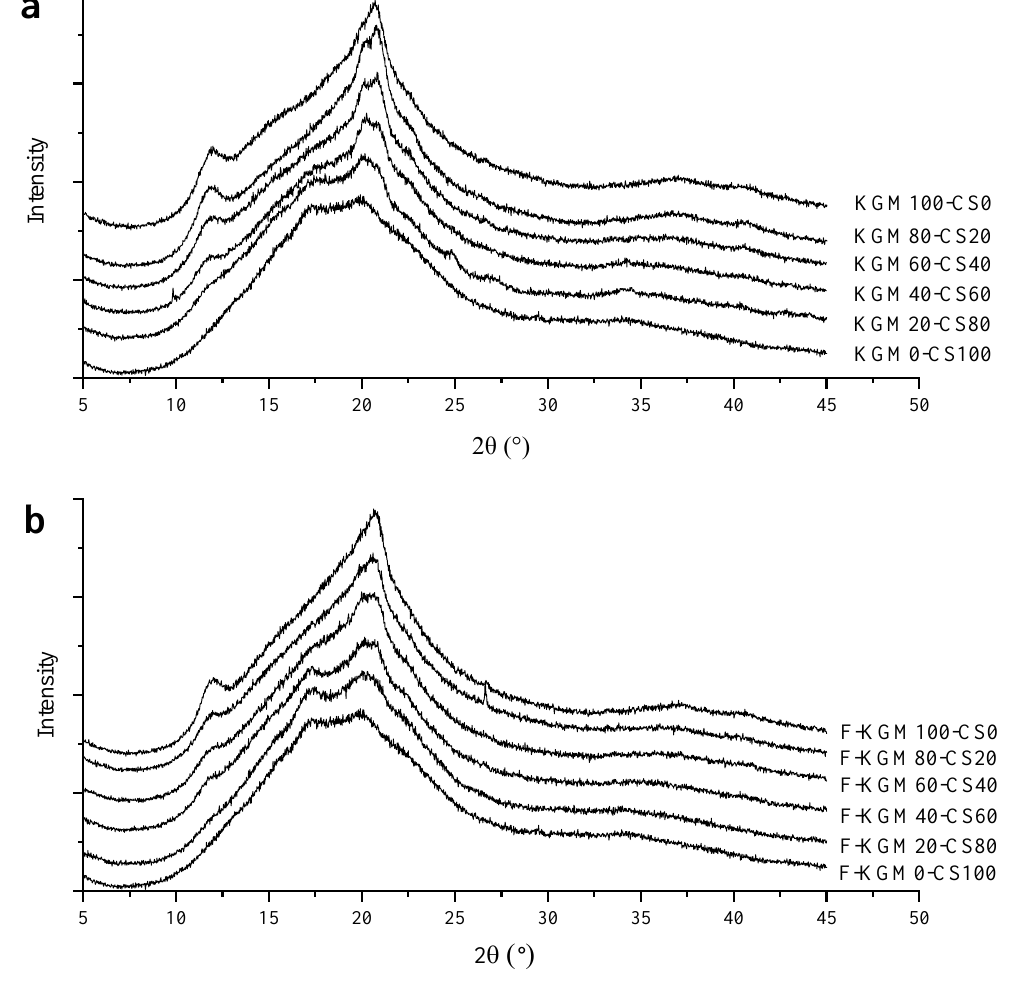
Figure 4. XRD profiles of the composite gels with different KGM/CS ratios: ( a ) KGM–CS gels; ( b ) F–KGM–CS gels. Table 1. The crystallinity of composite gels.